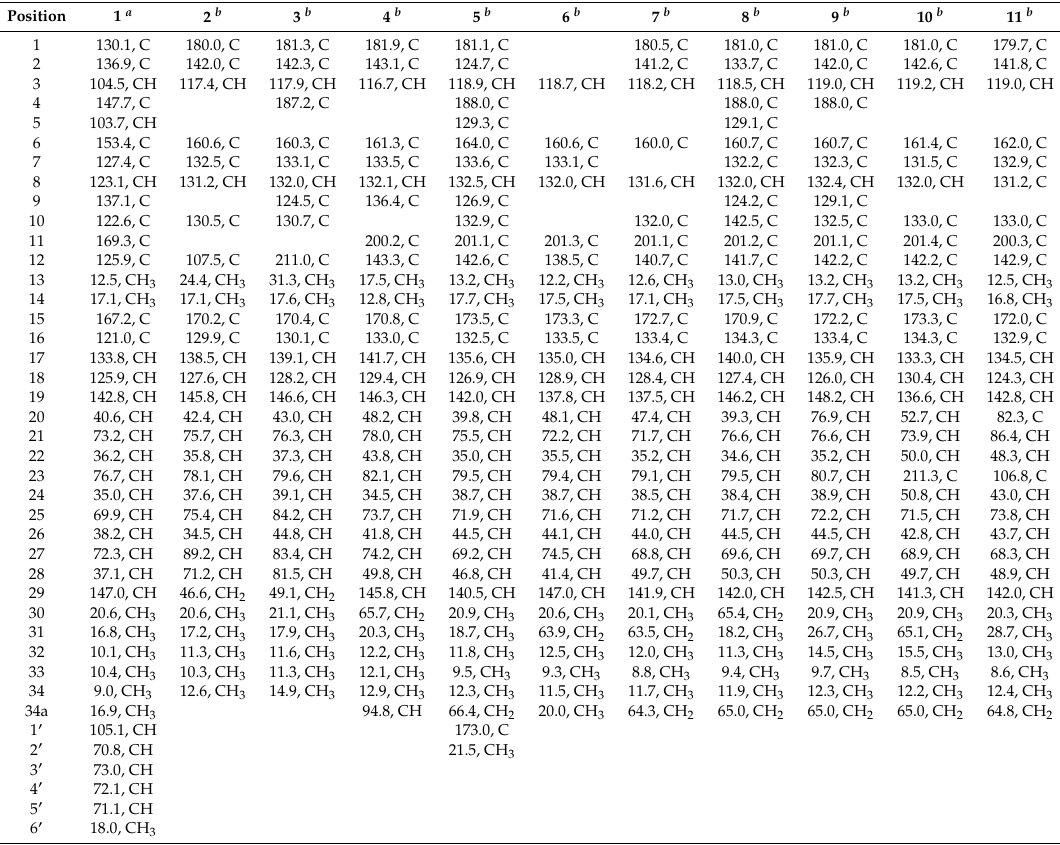
Table 2. 13 C NMR Spectroscopic Data of Compounds 1 – 11 ( δ C ).